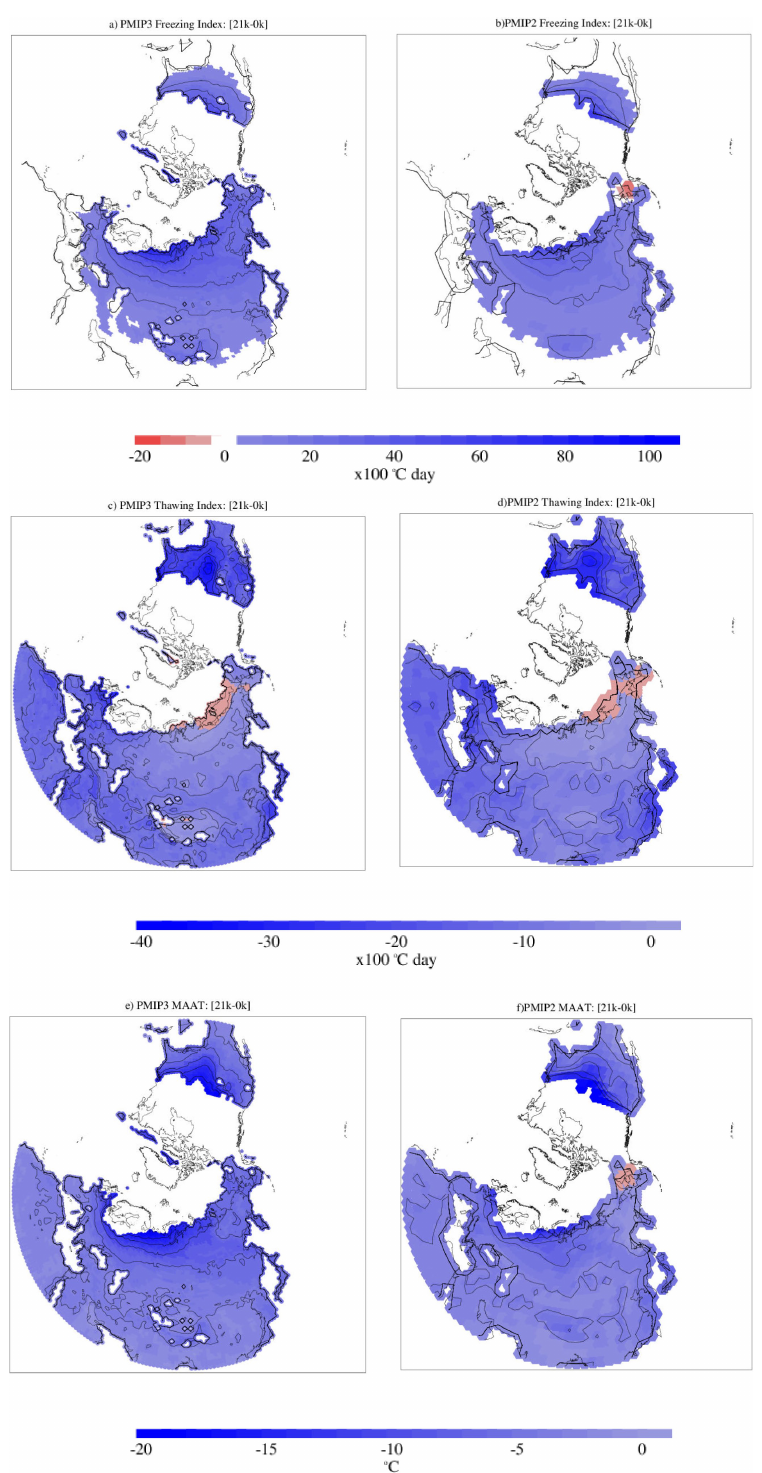
Fig. 1. Difference in freeze index at the LGM (21kya) from the pre-industrial period (0kya), computed from (a) the PMIP3 simulations and (b) PMIP2. (c) and (d) same as (a) and (b) except for the freeze index. (e) and (f) same as (a) and (b) except for mean annual air temperature at the surface